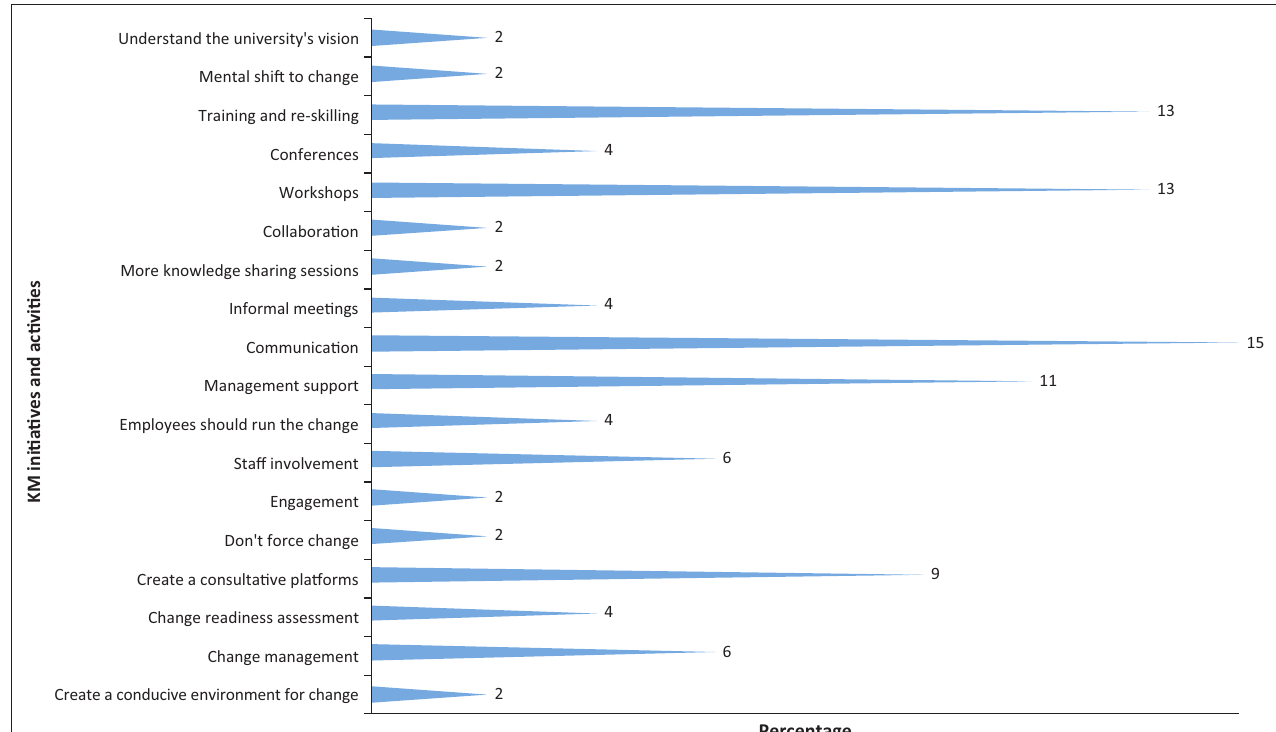
FIGURE 5: Knowledge management initiatives needed during change.